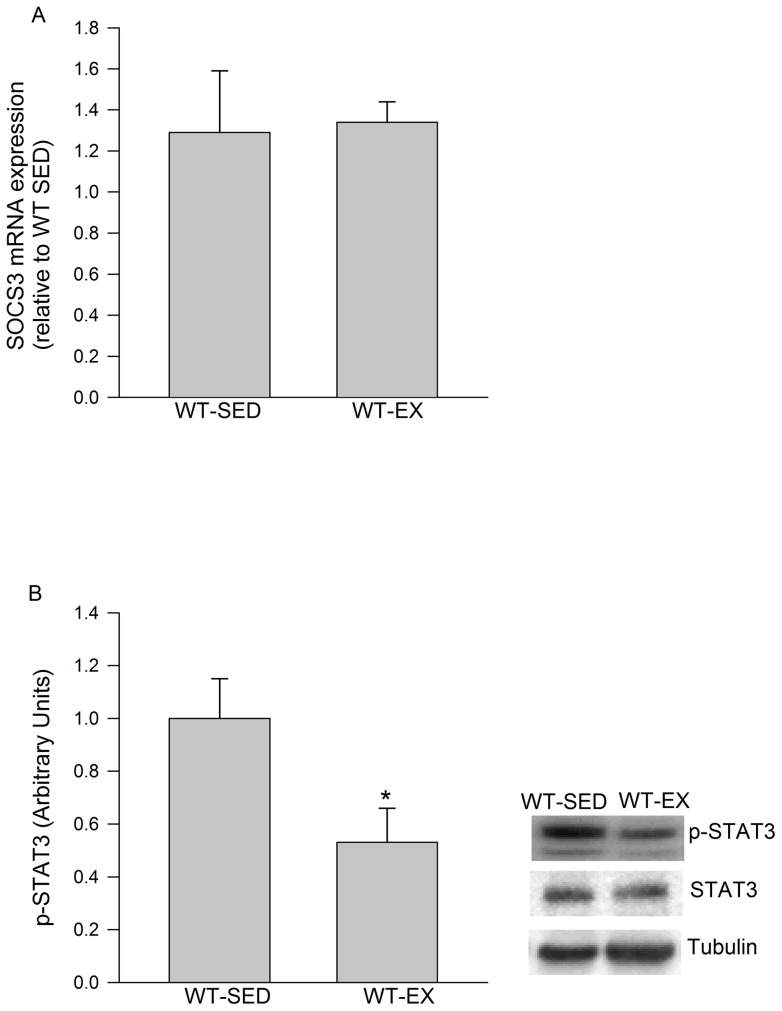
Markers of IL-6 signalling in adipose tissue following exercise.An acute bout of exercise does not activate IL-6 signalling in eWAT as demonstrated by A) unchanged SOCS3 mRNA levels and B) decreases in the phosphorylation of STAT3 (Tyr705). Data are presented as means + SE for 10 animals per group. The mRNA data is normalized to 18S and expressed as fold differences compared to the WT sedentary (SED) group in A. Representative Western blot images are given to the right of the quantified data in B. * P<0.05 versus WT SED.